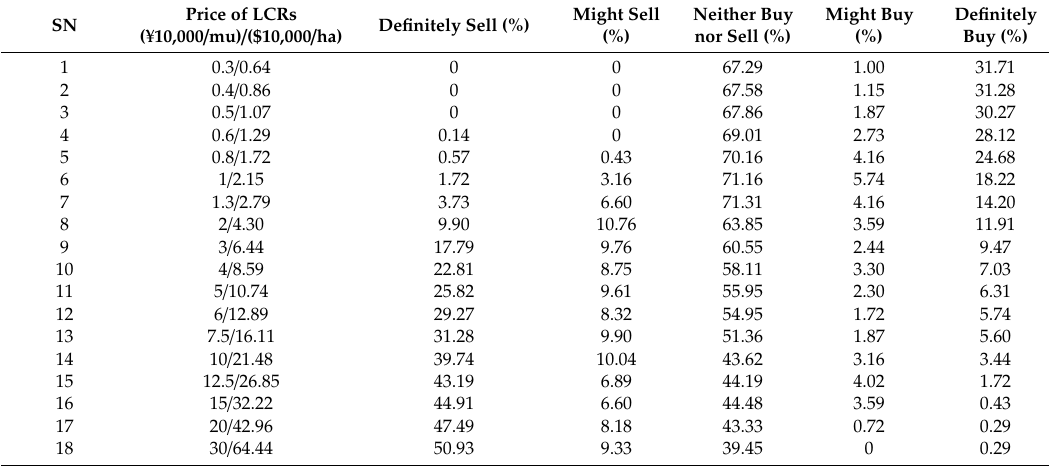
Table 4. Statistics on 697 households’ selection frequency. LCRs, land contract